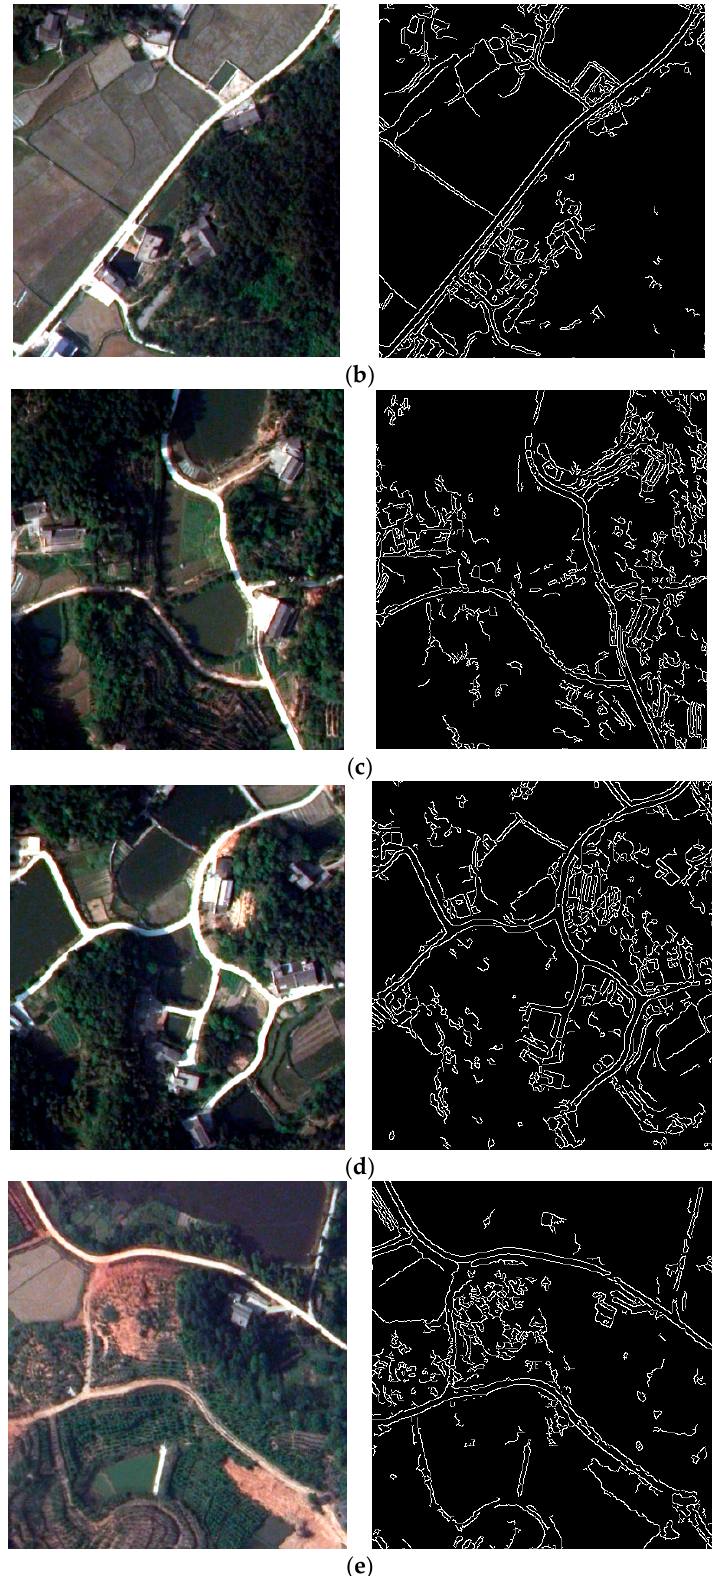
Figure 10. Edge detection result. ( a ) Detection result in the entire study area, ( b ) sample area 1, ( c ) sample area 2, ( d ) sample area 3, ( e ) sample area 4.